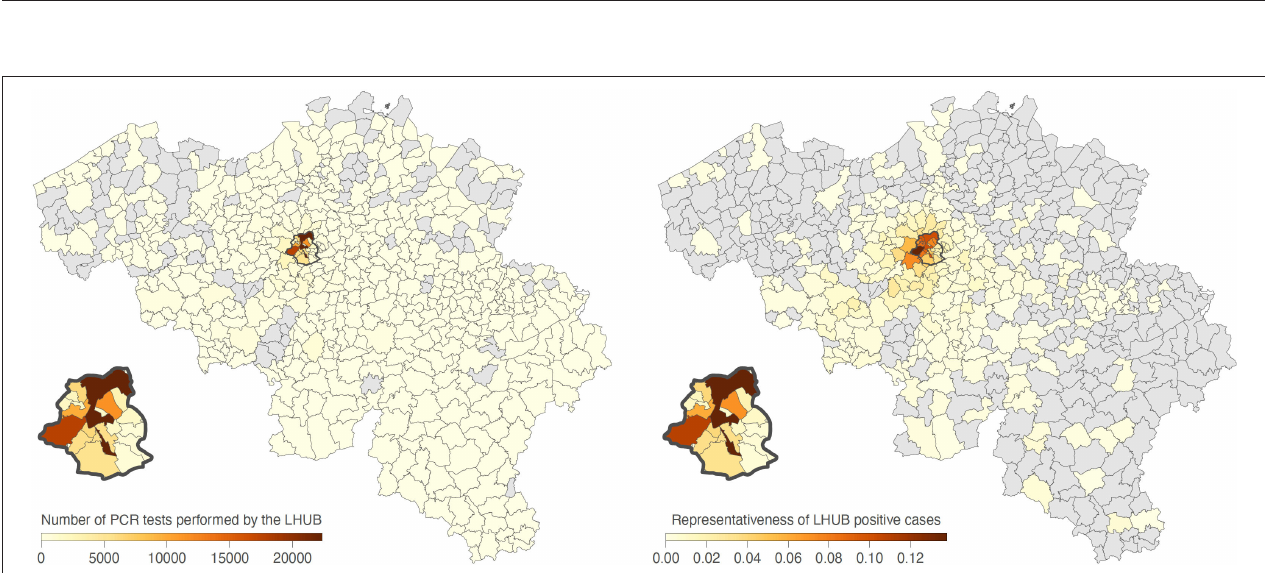
FIGURE 1 | COVID-19 trends in a laboratory perspective: evolution of the 14-day median (solid red curve) and mean (dashed red curve) Ct values obtained from April 1, 2020, to May 15, 2021 (LHUB-ULB, Brussels Region, Belgium). Reddish areas surrounding the solid red curve indicate the 95% confidence interval (CI) associated with median Ct values, and the thinner red dashed lines indicate the 95% CI associated with mean Ct values. The horizontal dashed line refers to the threshold value of 22.3. Those curves are superimposed on the evolution of the number of COVID-19 positive PCR test results at the LHUB-ULB. As detailed in the text, median and mean Ct values, as well as COVID-19 positive tests, were all computed using a backward 14-day sliding window. In the embedded box, we report the relationship between (i) the Spearman correlation between daily estimates of median (solid curve) and mean (dashed curve) Ct values and the number of COVID-19 positive tests (LHUB-ULB) and (ii) the time gap considered between the Ct measures and the number of positive tests. On top of the graph, we also report key dates of the Belgian epidemic.